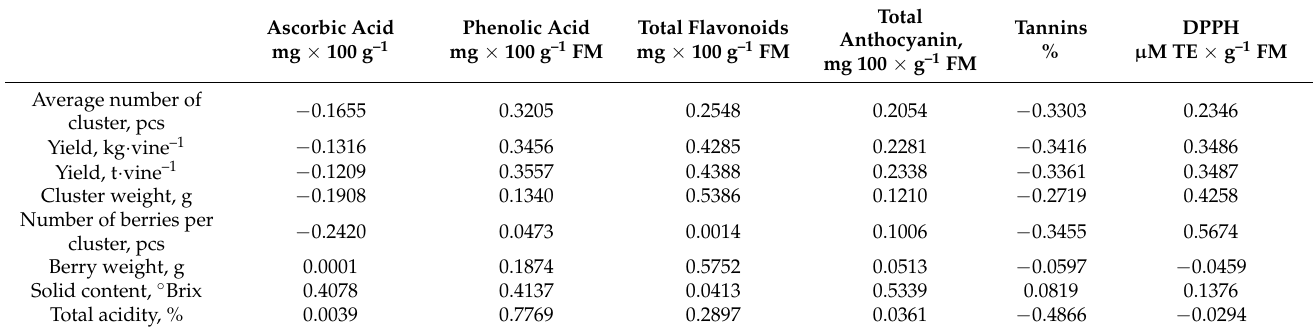
Table 3. Correlation coefficient for yield and quality parameters as well as biologically active com- pounds of Regent grapevine and their significance.